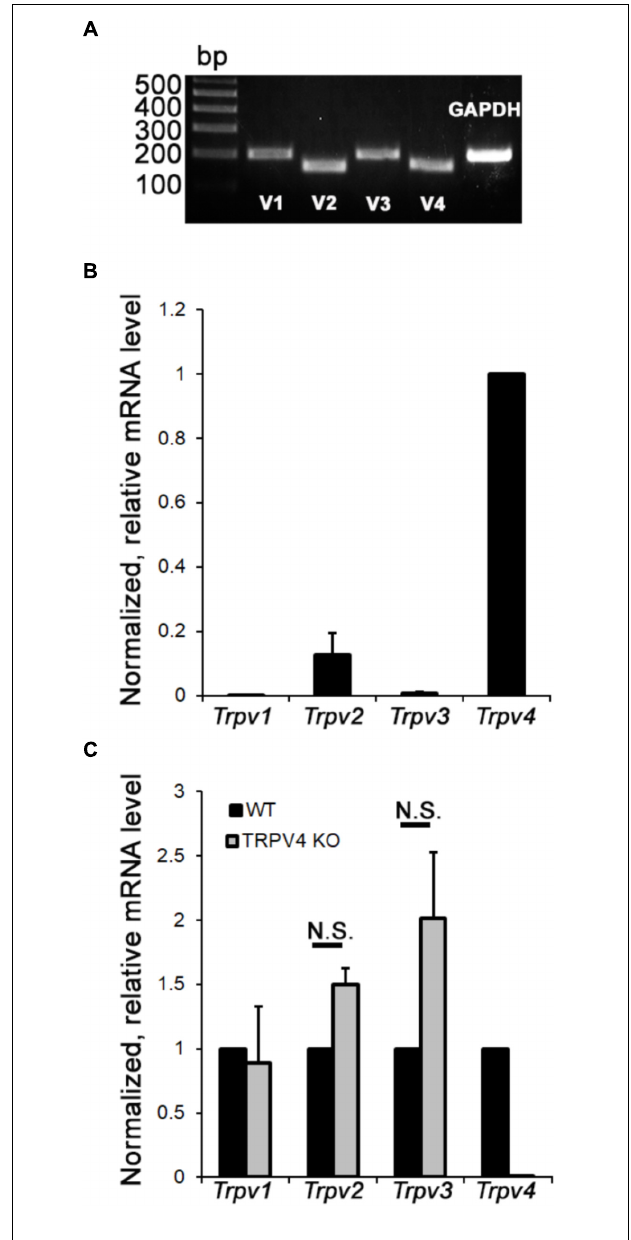
FIGURE 1 | Relative mRNA expression levels of vanilloid thermoTRP channels in primary mouse RGCs. (A) End point PCR. RGCs express all four thermo Trpv transcripts. Gapdh (glyceraldehyde 3-phosphate dehydrogenase) mRNA served as a loading control. (B) Semiquantitative RT-PCR. The relative abundance of thermo Trpv transcripts normalized with respect to Trpv4 content ( n = 4). (C) Fold change in mRNA expression in TRPV4 − / − RGCs ( n = 4) was calculated relative to expression in wild type